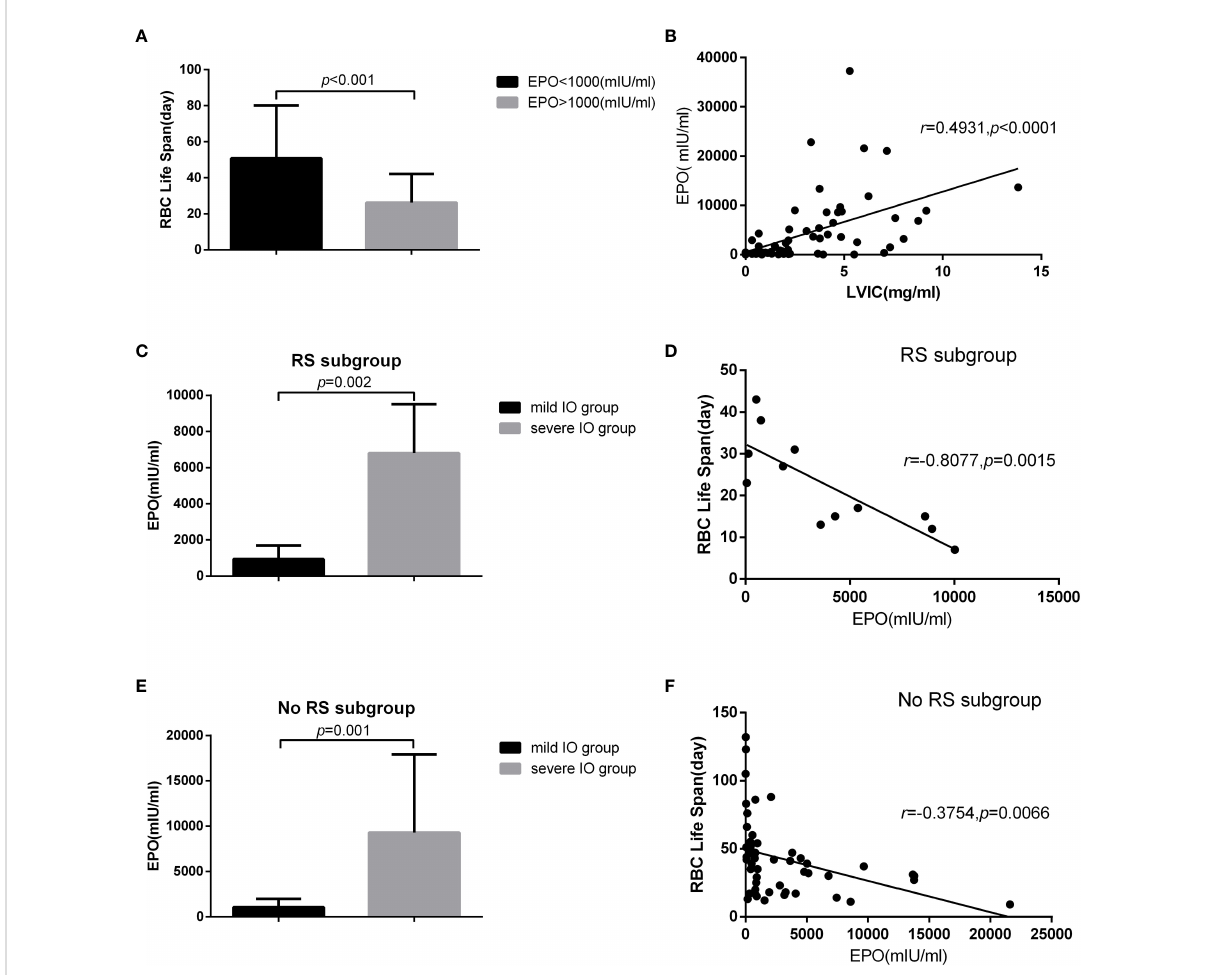
FIGURE 5 27 MDS patients in non IO group and 36 MDS patients in IO group who were not use EPO within one month were included in the analysis. There were 12 cases in MDS-RS and 51 cases in non MDS-RS subgroup. The results showed that: (A) the RBC life span in EPO>1000mlU /ml was signi fi cantly lower than that of EPO<1000mlU/ml (50.81±29.29 vs 26.23±15.87, p<0.001). (B) There was a signi fi cant positive correlation between liver VIC and EPO concentration ( r =0.4931, p<0.001). In MDS-RS subgroup, (C) EPO concentration in severe IO group was signi fi cantly higher than that in mild IO group (6802.50 ± 2709.02 vs 934.22 ± 763.49, p<0.001), (D) and EPO concentration was signi fi cantly negatively correlated with RBC life span (r=-0.8077, p<0.01). In the non MDS-RS subgroup, (E) EPO concentration in severe 10 group was also signi fi cantly higher than that in the mild IO group (9290.09±8638.86 vs 1050.10 ± 930.81, p<0.001), (F) and EPO concentration was signi fi cantly negatively correlated with RBC life span (r=-0.3754,